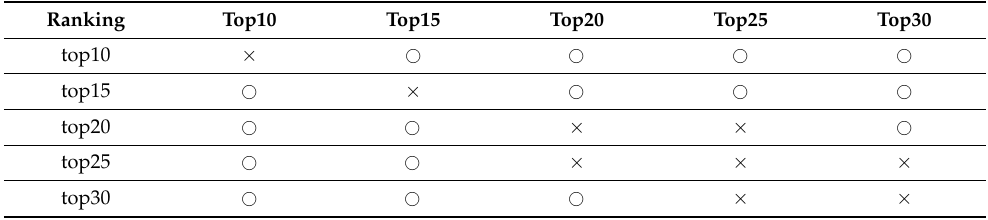
Table 3. The result when MME is taken based on the different rank of KGE. Also, it shows the differences for KGE in the calibration period.